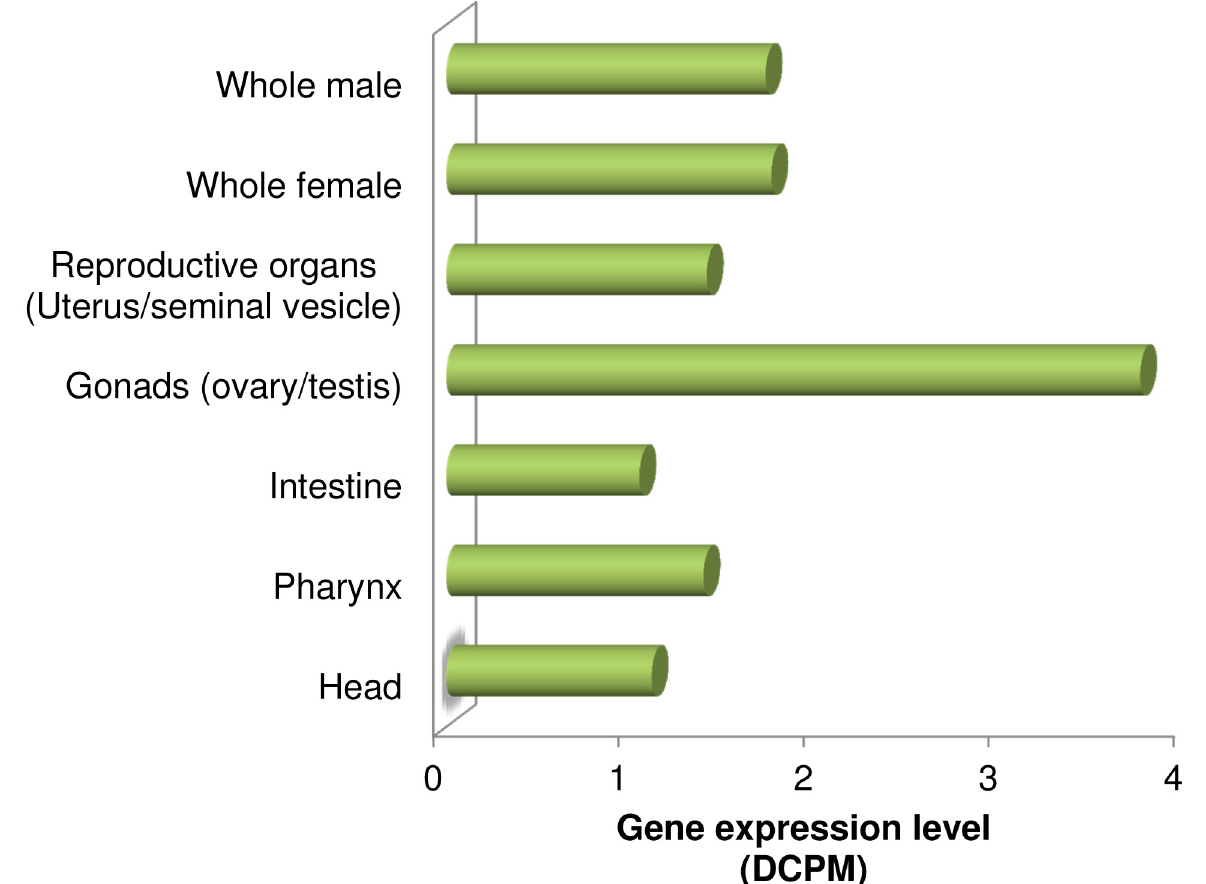
Fig 3. Expression level of A . suum KDAC1 gene (GS_10652) in different tissues. Gene expression values are in depth of coverage per million reads (DCPMs). The expression values are averaged across male and female samples.